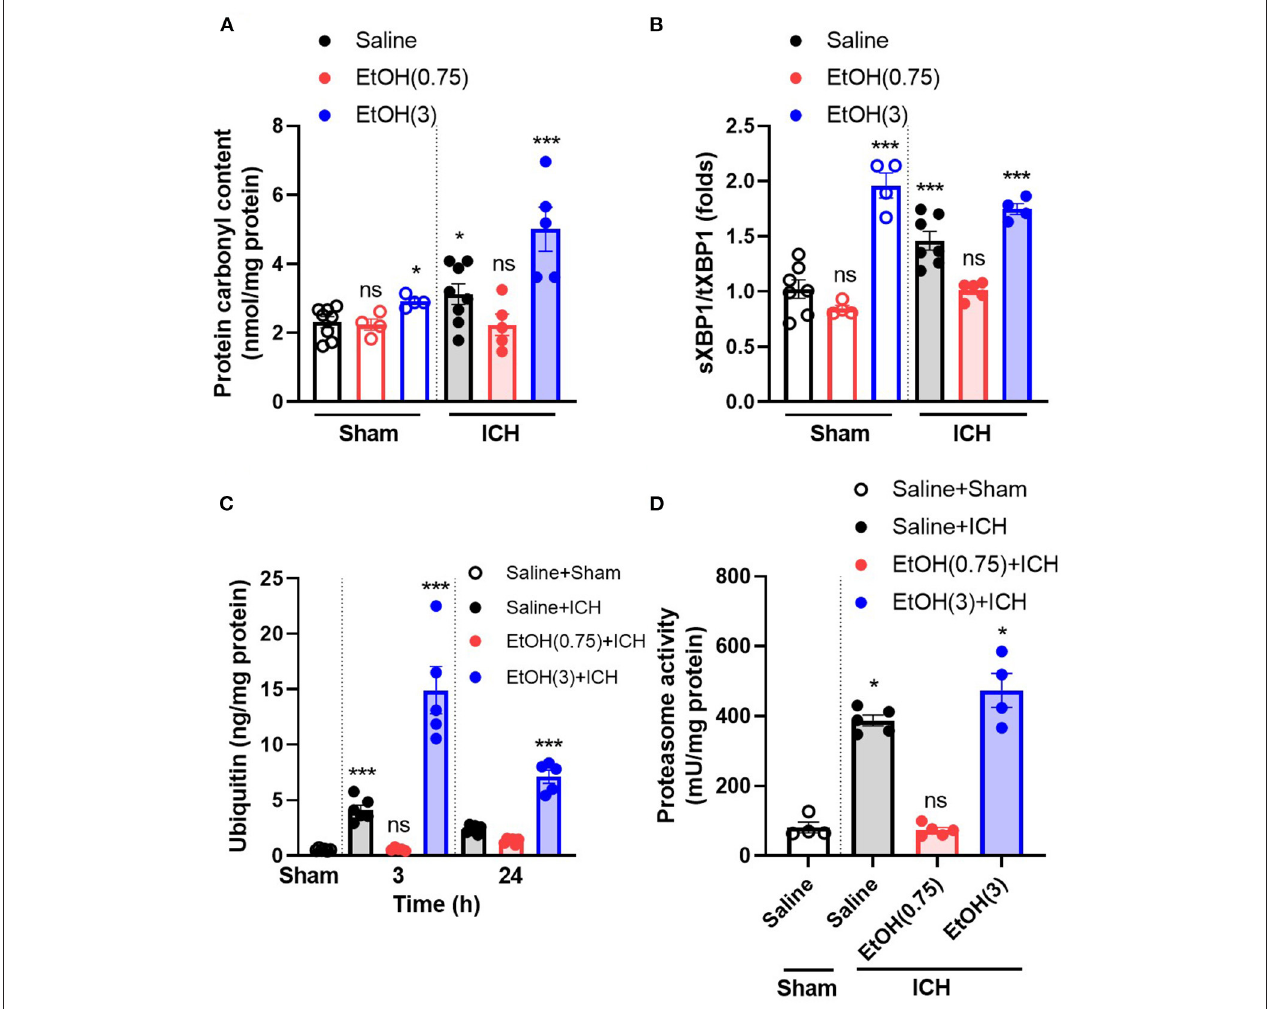
FIGURE 3 | Moderate ethanol pre-conditioning restored the ICH-induced cytotoxicity and the disruption of protein homeostasis. (A) The level of protein carbonyl group was indicated as oxidative stress marker on day 1 post-ICH in each group ( n = 4–8). * p < 0.05 and *** p < 0.001 as compared to sham group with ethanol administration. All the data were analyzed as repeated measures by one-way ANOVA followed by Tukey’s test for post-hoc analysis. (B–D) The ratio of spliced XBP1 to total XBP1 ( n = 4–7) (B) , ubiquitin content ( n = 5) (C) , and proteasome activity ( n = 4–5) (D) was indicated as the marker of unfolded protein response. *** p < 0.001 as compared to sham